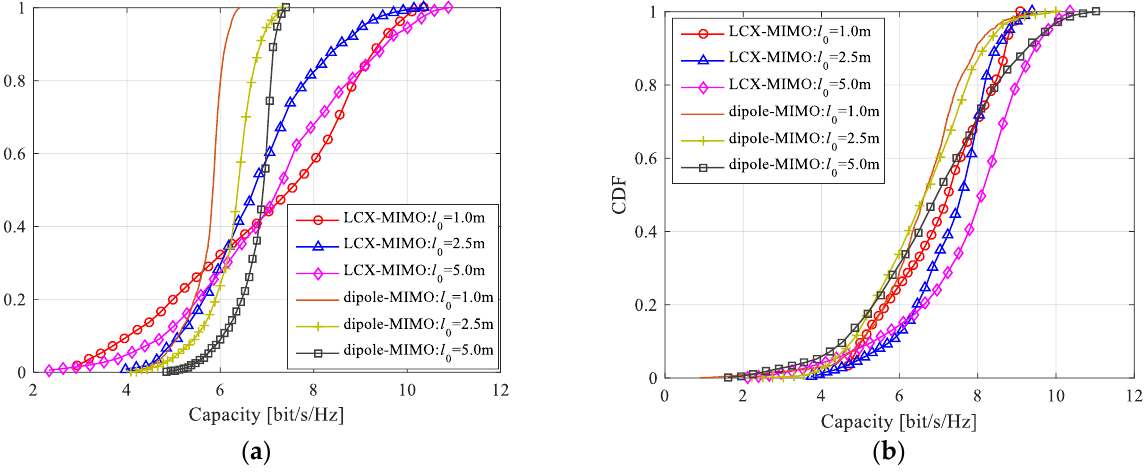
Figure 14. Channel capacity for LCX MIMO system and dipole antennas MIMO system: ( a ) LoS only path; ( b ) both LoS and NLoS paths.